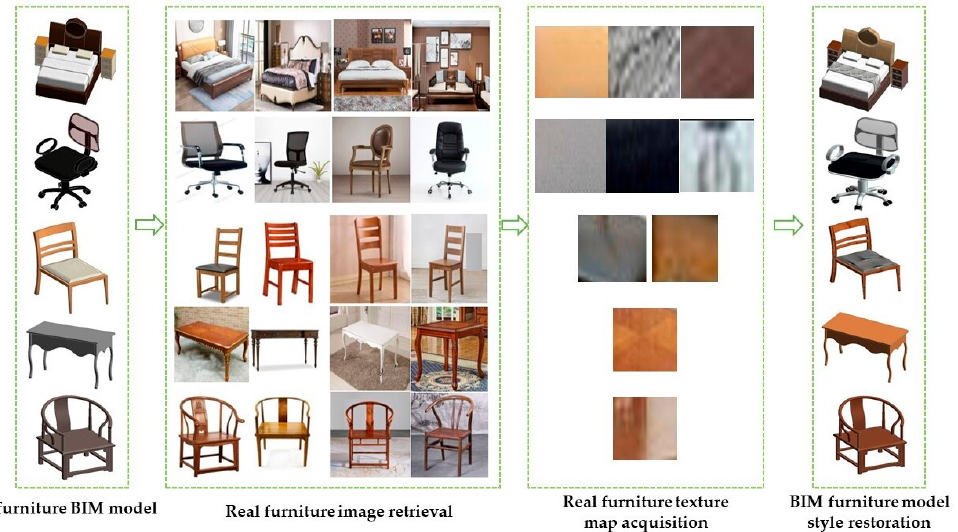
Figure 9. Examples of the furniture BIM style restoration.